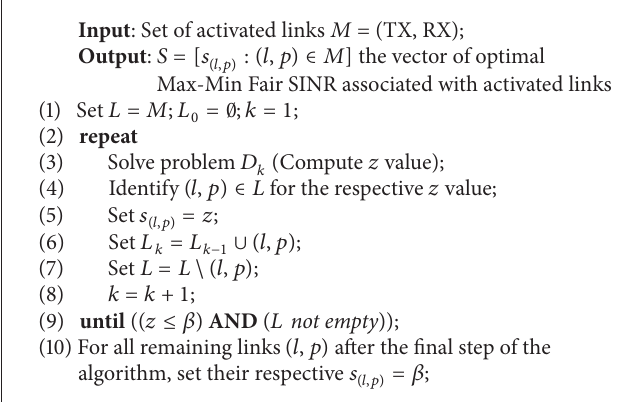
Algorithm 1: MMF algorithm (optimal max-min fair SINR link transmission).